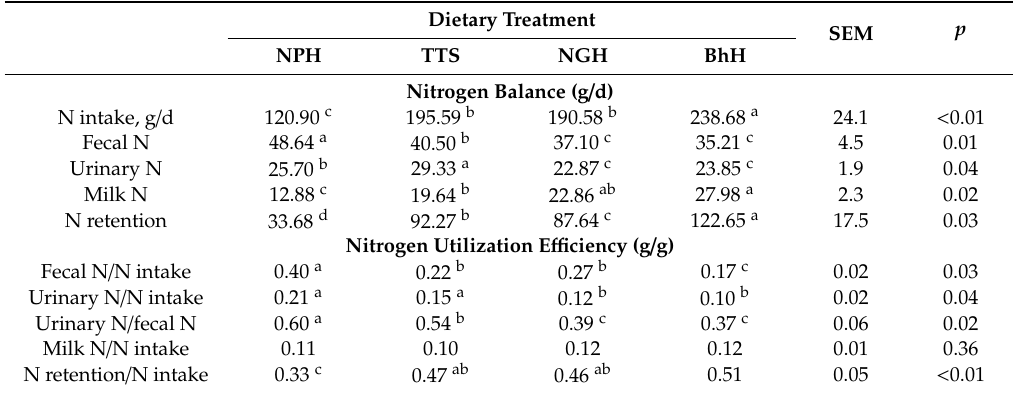
Table 3. Nitrogen utilization and balance of lactating dairy cows fed natural pasture hay, treated te ff straw, Napier grass hay, and Brachiaria hybrid grass